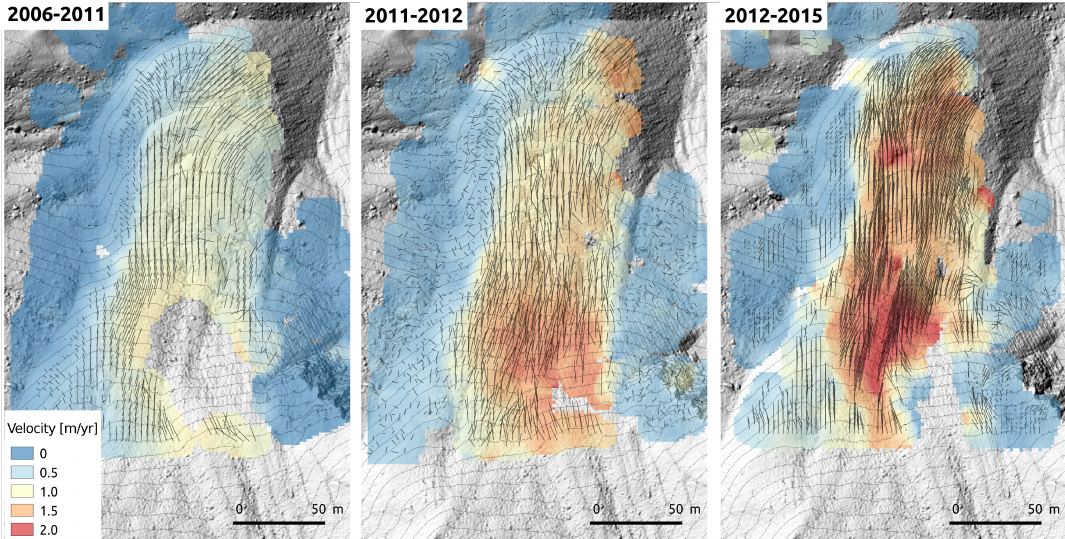
Figure 4. Maps of the surface velocity of the Laurichard rock glacier at three different time periods, as derived from image correlation using HR